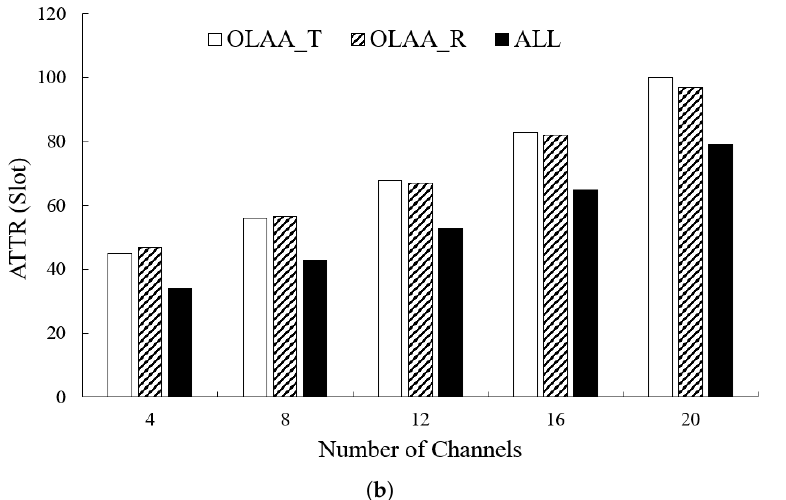
Figure 6. This figure displays the impact of the number of channels on the bottleneck topology’s performance in a synchronous network, as measured by two metrics: ( a ) throughput and ( b ) ATTR.